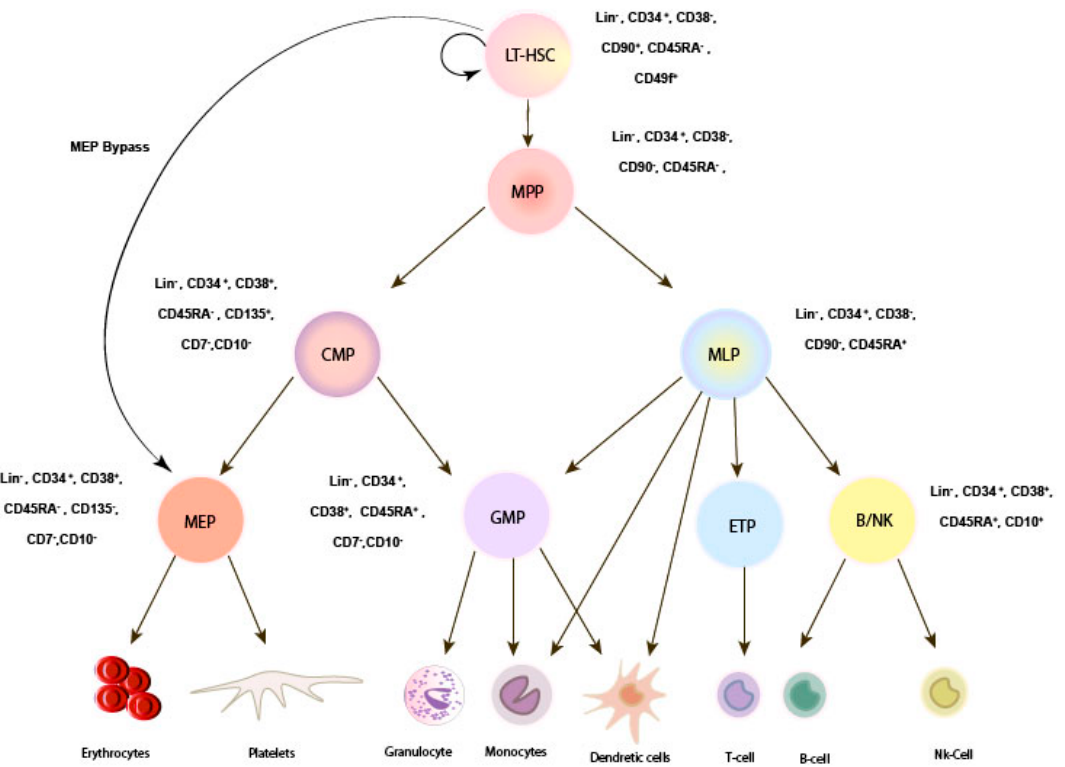
Figure 1. Revised model for human HSC hierarchy. In the classic model for the human HSC hierarchy LT-HSCs are defined by CD34+ CD38- CD45RA- CD90+CD49f+ which differentiates into MPPS, CMPs, MLPs, GMPs. However, in a revised model, HSCs can differentiate directly into MEPs by bypassing CMP (here shown as MEP bypass route). LT-HSC: long-term hematopoietic stem cell. MLP: multipotent progenitor, CMP: common myeloid progenitor, GMP: granulocyte/macrophage progenitor, MEP: Megakaryocyte-erythrocyte progenitors.